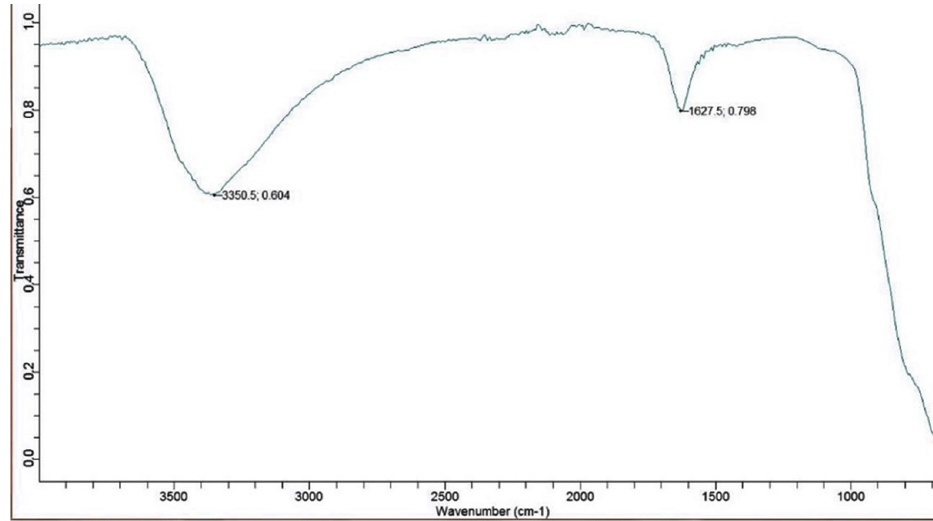
Figure 3. FTIR spectrum of g-C 3 N 4 -CoWO 4 .